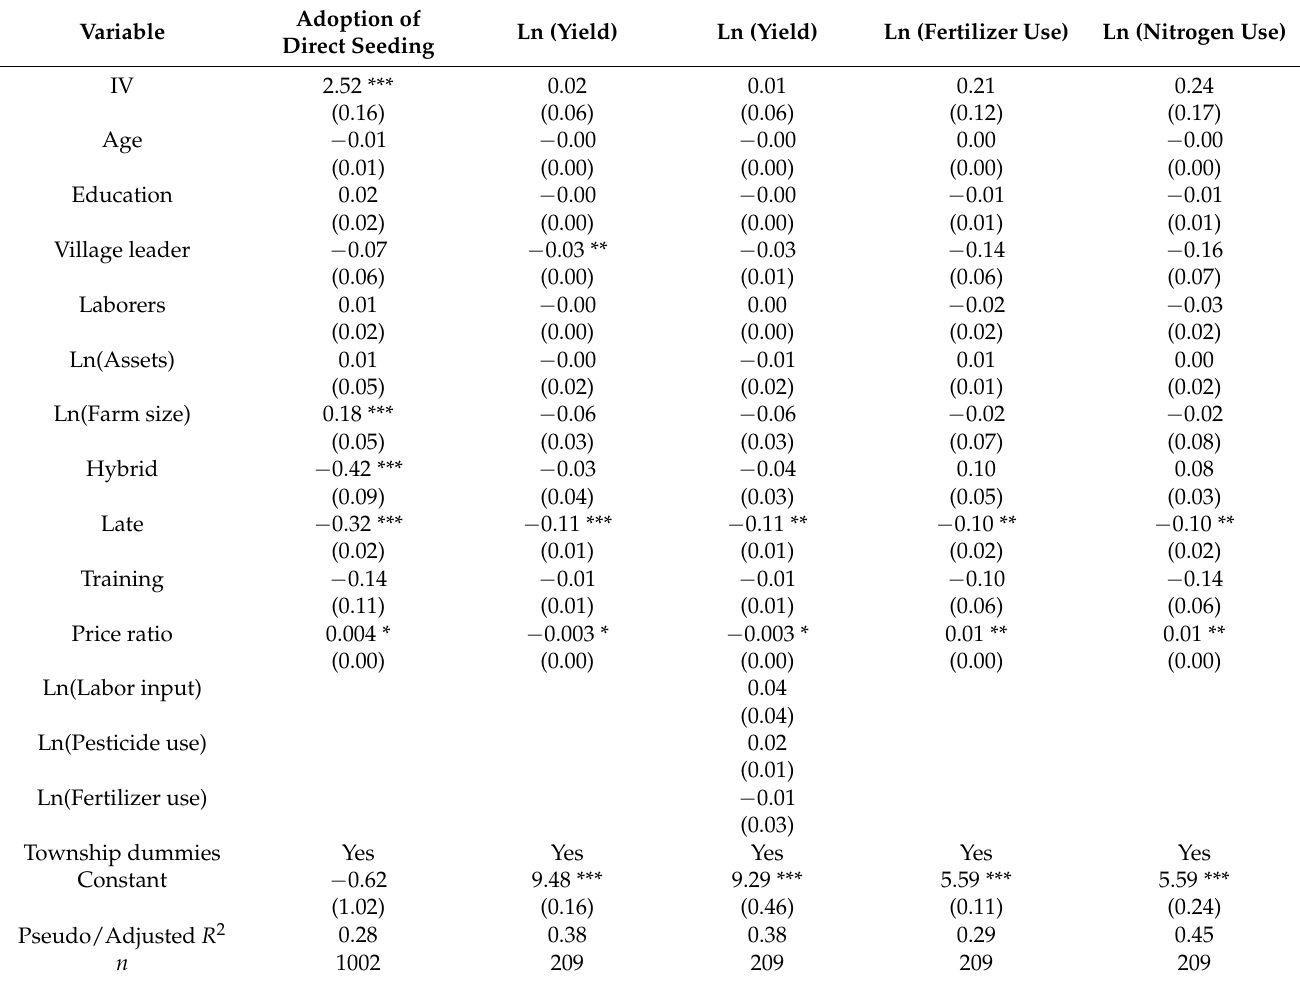
Table 4. Results of the falsification test for the instrumental